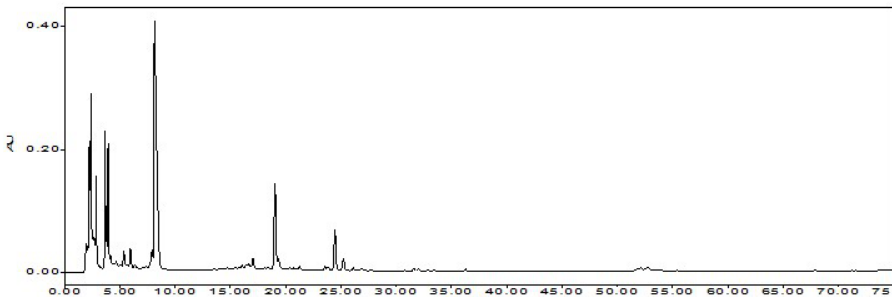
Figure 3. The chromatogram of NHPR.